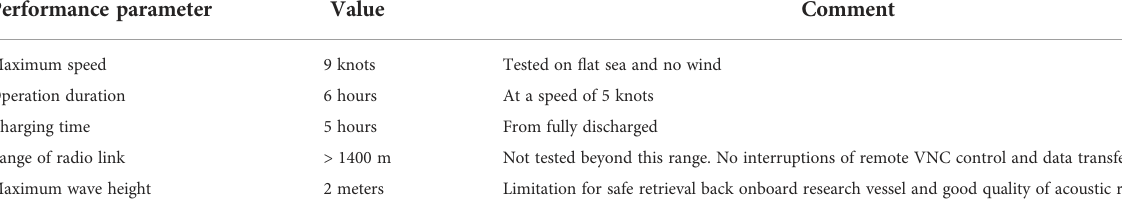
TABLE 2 Summary of measured performance parameters of the Kayak Drone.